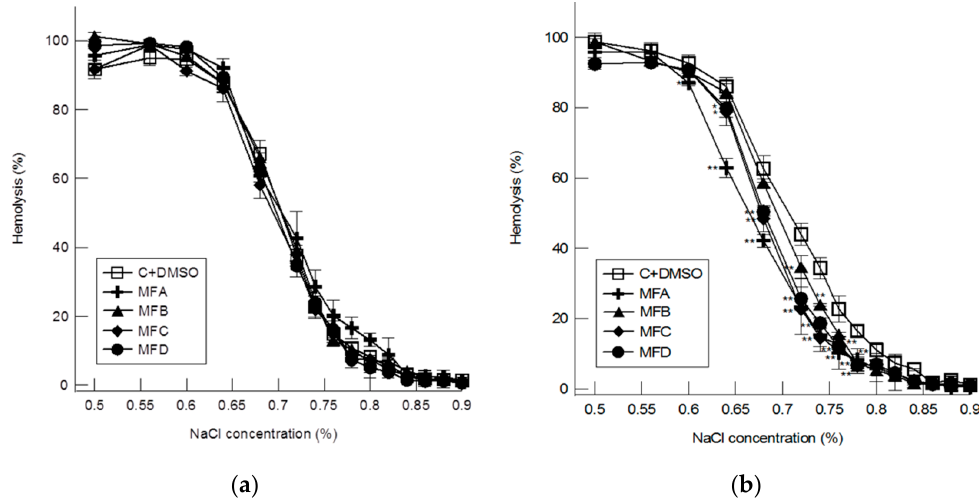
Figure 4. The relationship between the percentage of hemolysis of control and compounds modified RBCs vs. the percentage of sodium chloride (NaCl). The compounds were used at 25 µM ( a ) and 50 µM ( b ) of concentrations. The experiment was carried out in three replicates, the results were presented as mean ± standard deviation. Statistically significant differences are marked: * α = 0.05; ** α = 0.01.